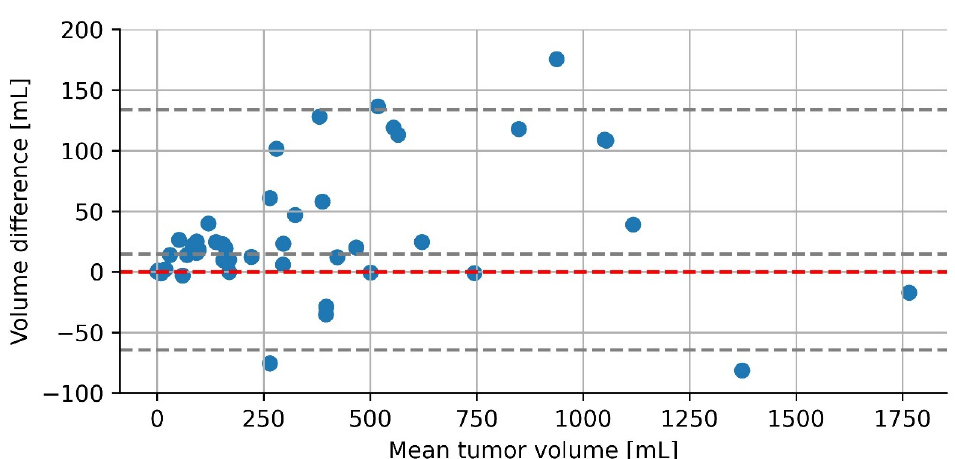
Figure 3. Radiological vs. manual-based tumor volumes. The volume difference plotted on the y-axis was calculated by extracting the radiological tumor volumes from the manually measured reference volume. The red line corresponds to no difference with the manually determined reference volume. Because radiological tumor volume was subtracted from the reference volume, a point above the red line presents an underestimation of tumor volume by the radiologist while points below the line represent an overestimation of tumor volume. In grey, the median and 2.5–97.5 percentile are plo tt ed.